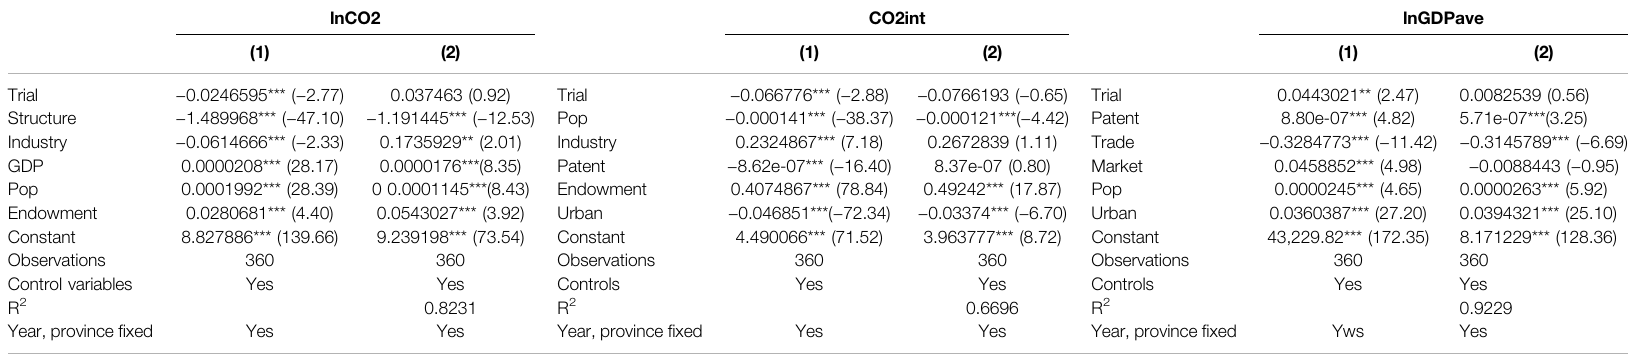
TABLE 5 | Robustness test